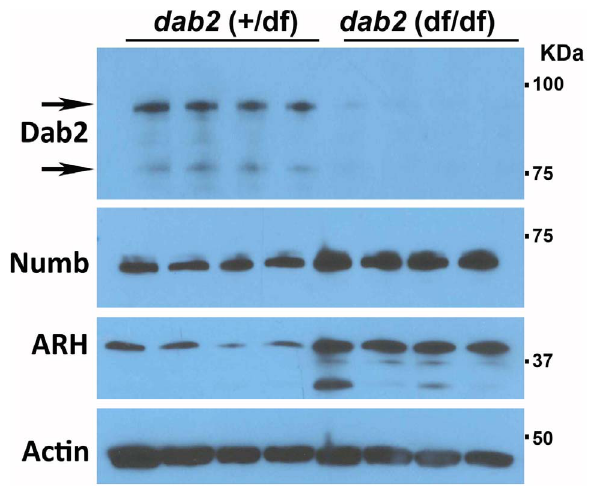
Figure 9. Compensatory expression of ARH and Numb in Dab2 null mammary epithelial cells. Dab2, ARH, and Numb proteins were analyzed by Western blotting of primary mammary epithelial cells isolated from control ( dab2 wildtype and heterozygous ( dab2 ( + /df)) and conditional knockout ( dab2 (f/df); Meox2-Cre) 16.5-day pregnant mice. Based on quantitation using Image J and averaging the outputs, Numb increased 2.1-fold and ARH increased 4.3-fold in Dab2 null cells.